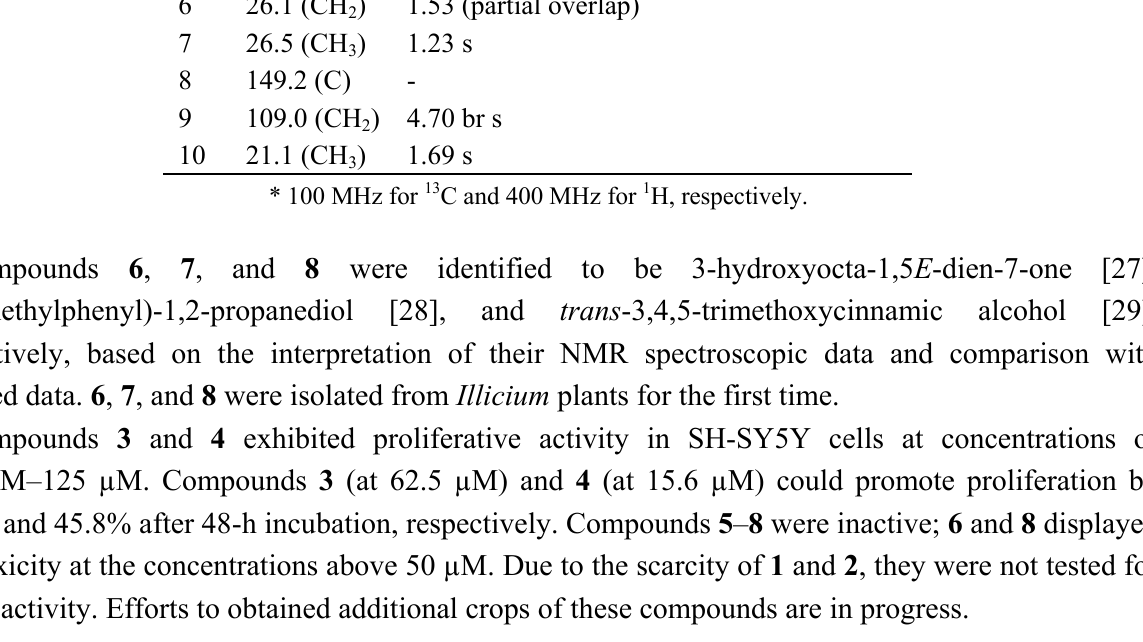
Table 3. 13 C- and 1 H-NMR spectroscopic data for compound 5 (CDCl No. δ C